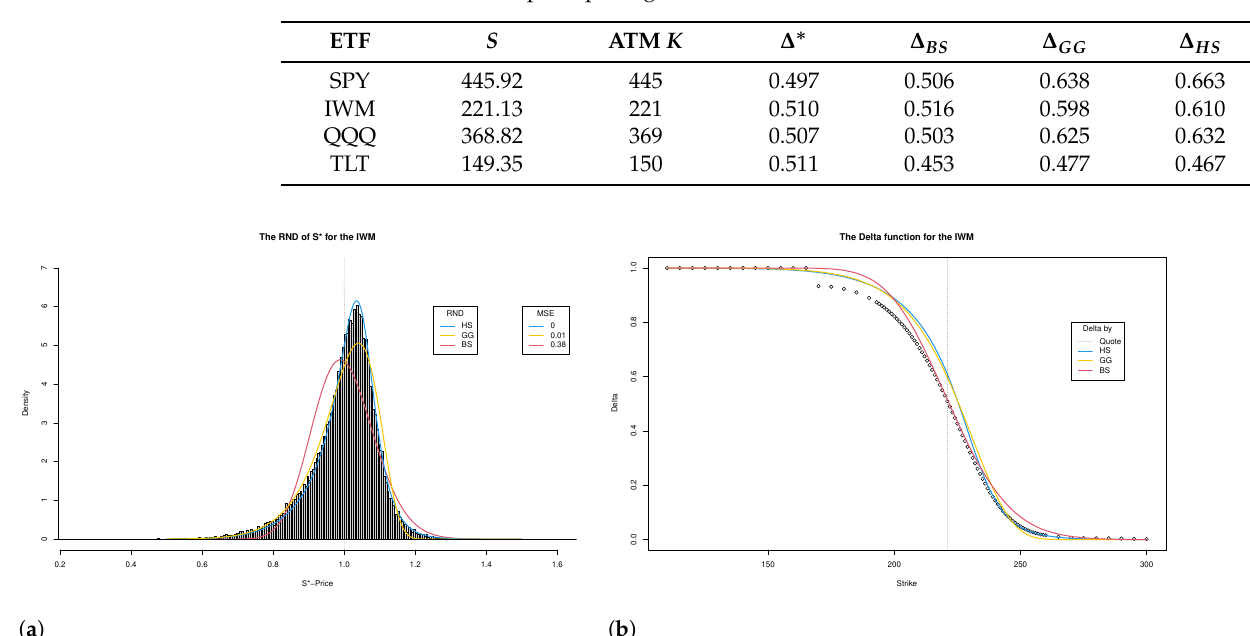
Table 3. Comparison of the the quoted ATM delta ∆ ∗ of the four market ETF to those calculated under each of the three option pricing models.